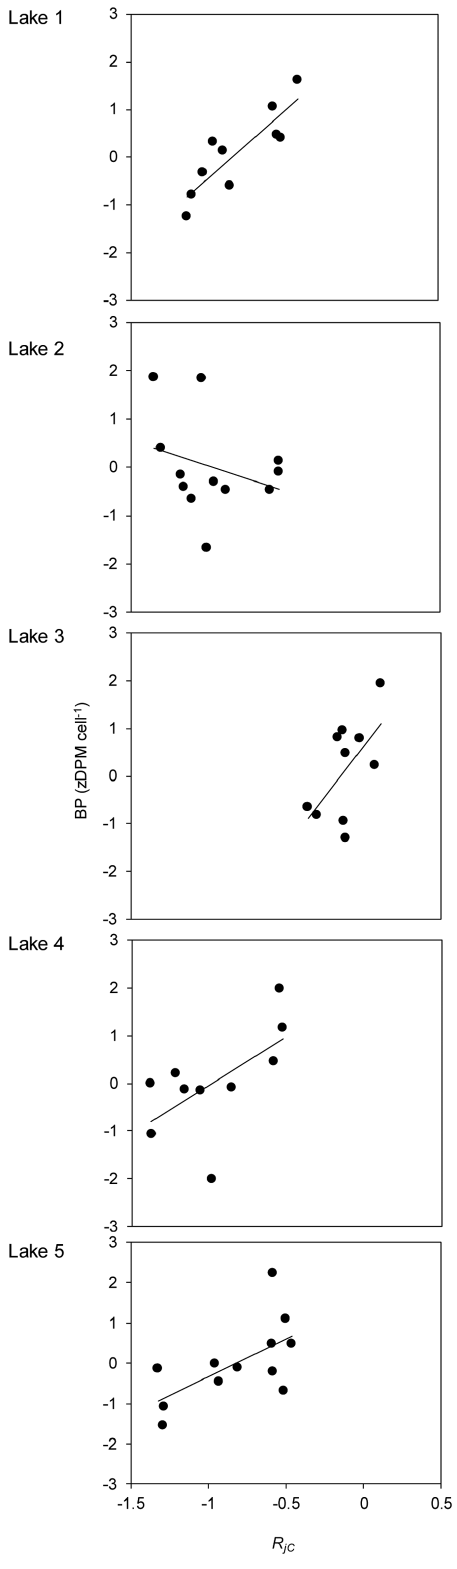
Figure 3. Association between functioning and the average ability of the community to grow on p-coumaric acid. Community functioning is assessed as per cell bacterial production.